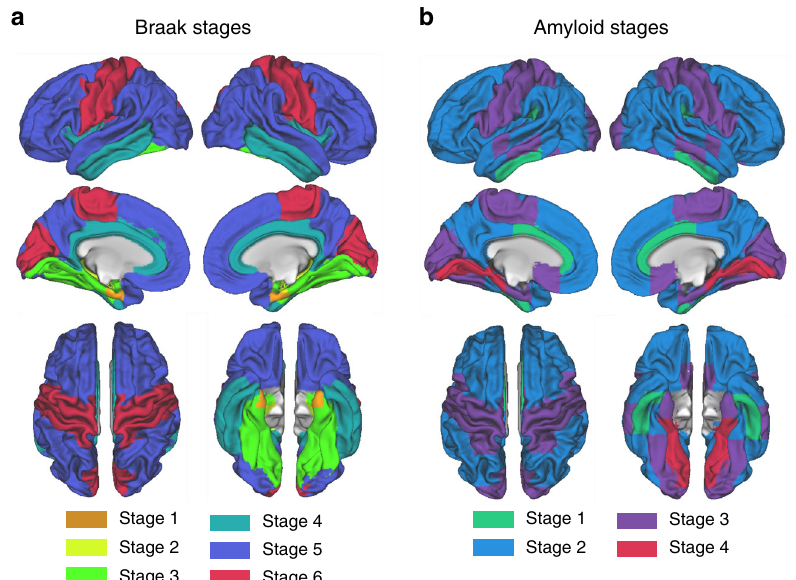
Fig. 1 Staging systems for tau- and amyloid-PET. Spatial mapping of Braak- ( a ) and amyloid stage-speci fi c ROIs ( b ) that were used to determine regional AV1451 tau- and AV45 amyloid-PET uptake within the sample of n = 89